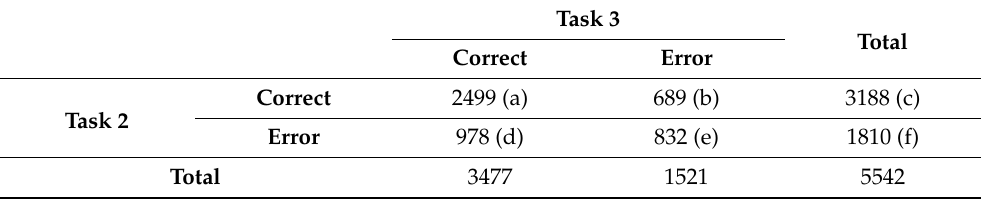
Table 6. Confusion matrix of tracking performance in correct case of Task 1.